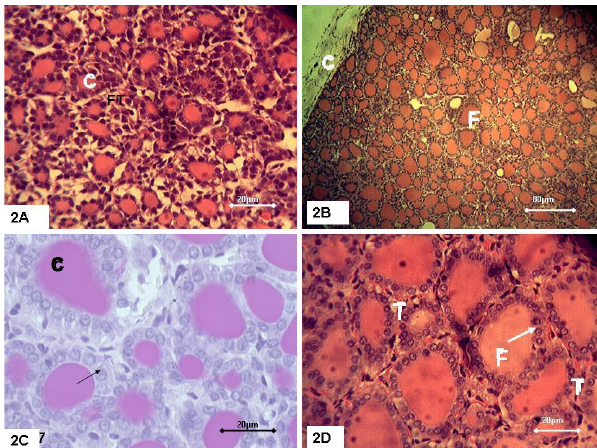
Fig. 2A. Photomicrograph of sections of 50-70 days WADG, showing the presence of small follicles (arrows) with few cells (4-7), filled with eosinophilic colloid, H & E (scale bar 20 μm); Fig. 2B. Photomicrograph of thyroid sections of foetal WADG (75-90 days), showing maturing capsule (C), small follicles in the periphery and medium-sized follicles with large-sized follicles (F) predominant in the inner zone of the glands; some follicles without colloid. H – E (bar scale 80 μm); Fig. 2C. Sections 75-90 days thyroid showing increased number of follicular cells (arrow) and deeply stained PAS-positive colloid (C). PAS (scale bar 20 μm); Fig. 2D. Thyroid sections of 75-90 days showing increased number of follicular cells from the previous age, Follicular lumen (F) and Parafollicular cells (arrow) apparent. Note a well vascularised interfollicular tissue (T). H – E (bar scale 20